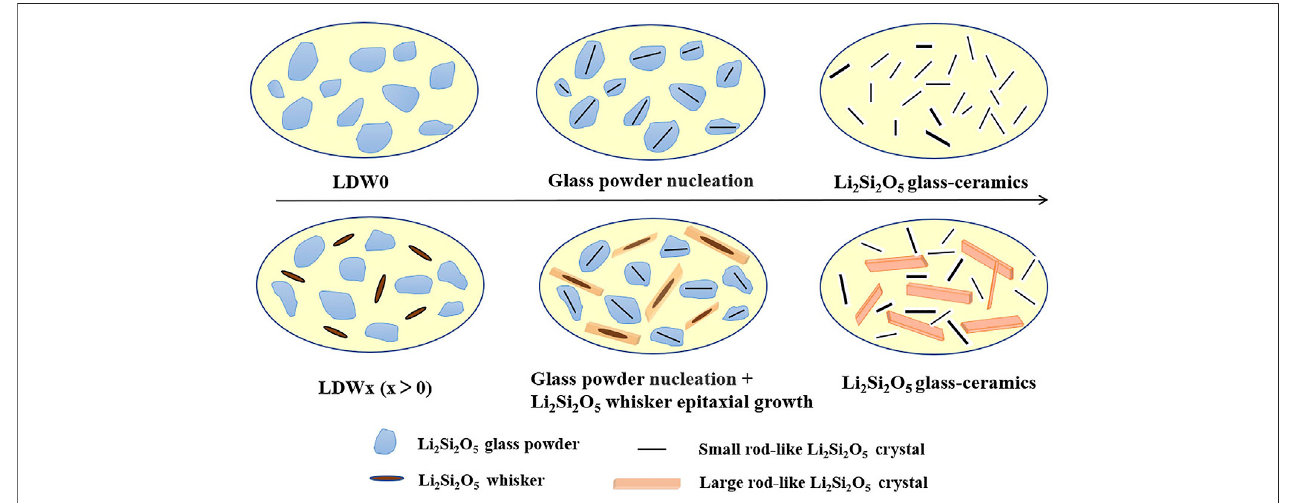
FIGURE 6 | Flexural strength and fracture toughness of the Li 2 Si 2 O 5 glass-ceramics with different compositions.